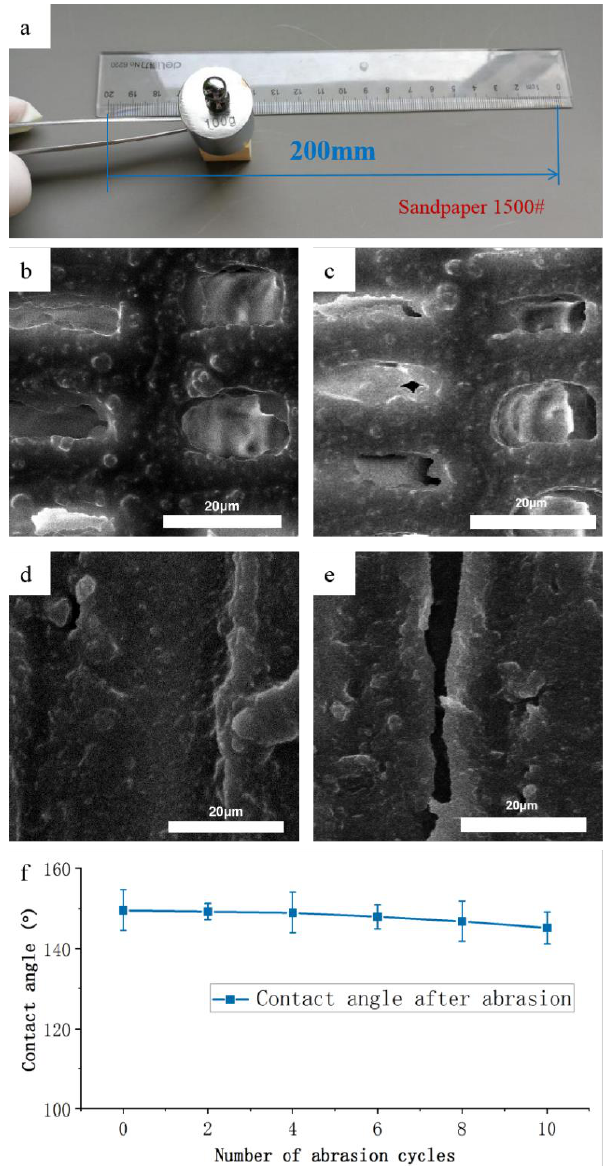
Figure 10. Abrasion resistance test of hydrophobic surface on wood. ( a ) Illustration of the sandpaper abrasion test; ( b ) cross section of wood before abrasion test; ( c ) cross section of wood after abrasion test; ( d ) tangential section of wood before test; ( e ) tangential section of wood after abrasion test; ( f ) the water contact angle as a function of number of abrasion cycles for hydrophobic wood surface.